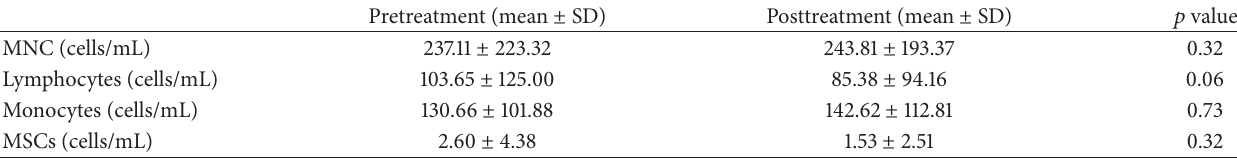
Table 2: Phenotypic characterization of the cell population in SF of IA group.